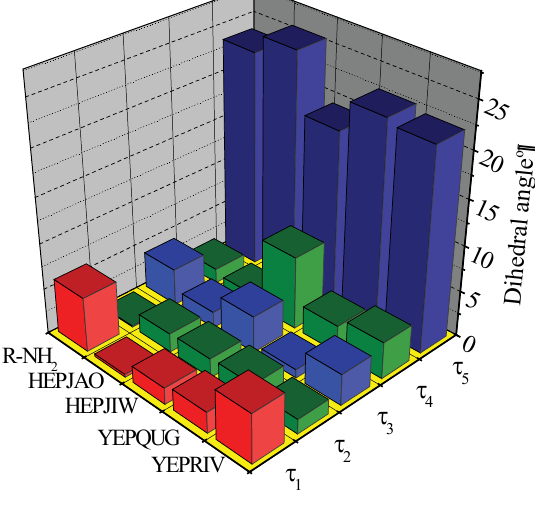
Figure 1. Dihedral angle ti values (Scheme 1) for different substi- tuted malononitriles; CCDC codes are given for crystallo- graphic-studied